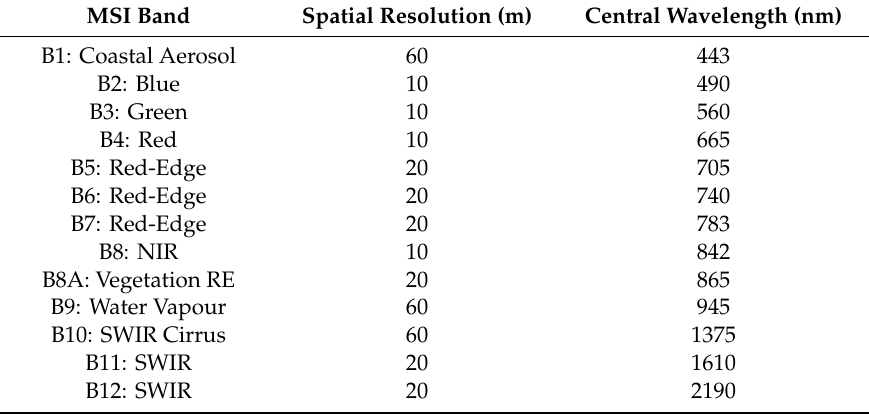
Table 5. Vegetation indices calculation regarding Sentinel-2 bands, B refers a specific band, among those reported in Table 4. The acronyms refer to: chlorophyll index green (CI green), chlorophyll index red edge (CI red edge), normalized di ff erence water index (NDWI), the modified